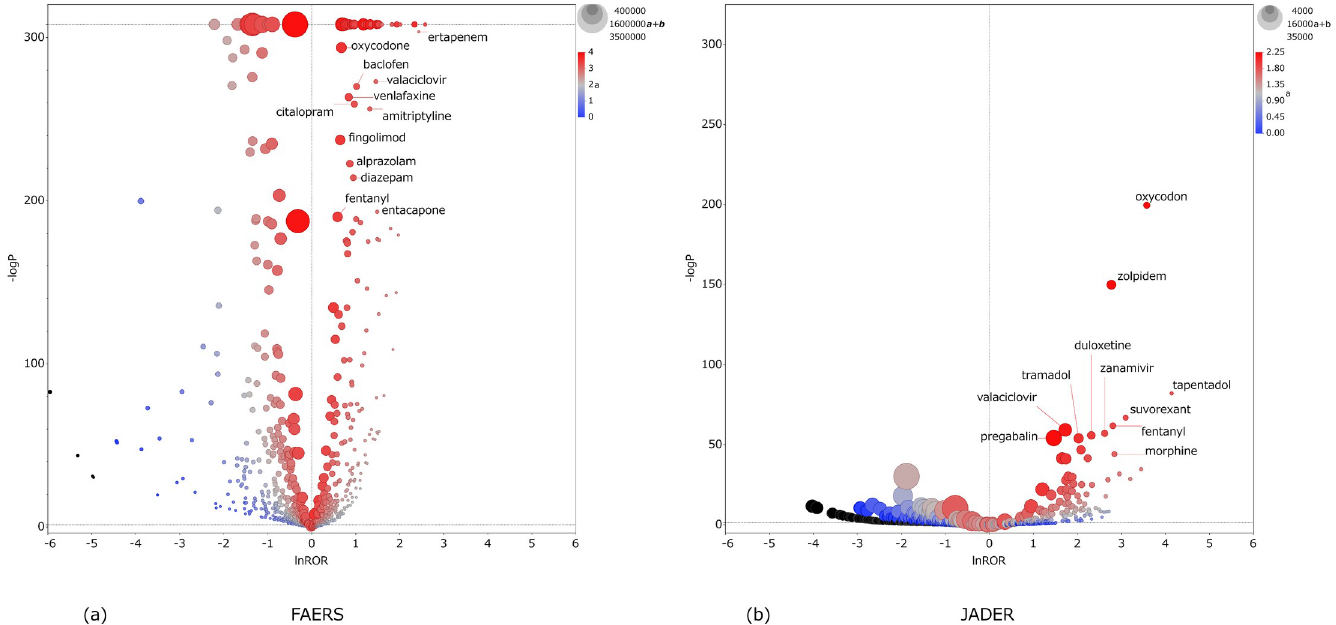
Fig 3. Scatterplot of CNS. Tendency of inducing CNS anticholinergic AEs by each drug. (a) FAERS and (b) JADER.